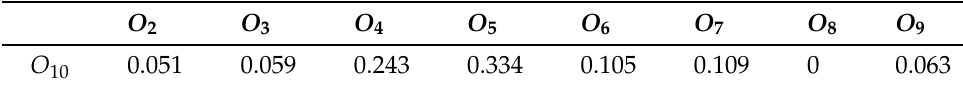
Table 5. The similarity matrix of O 10